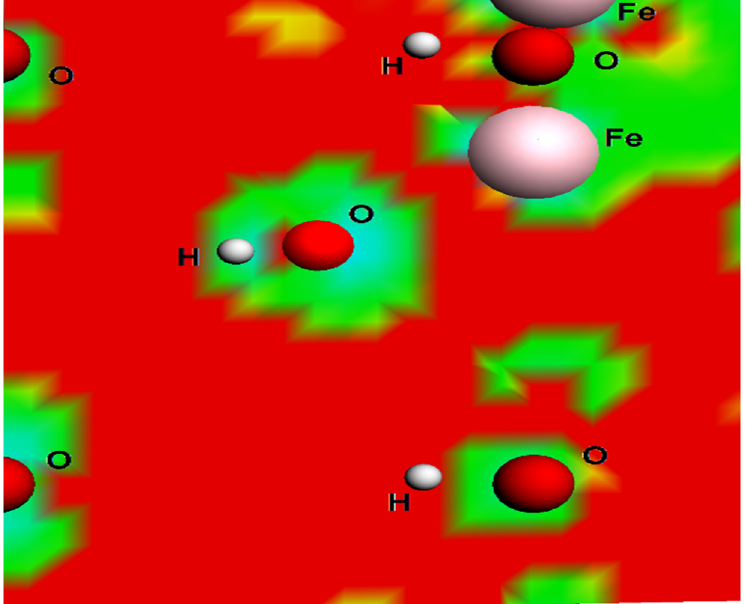
Figure 7. Electrostatic surface contours of (cid:2012) -FeOOH plane (100). Red and green indicate volumes of low electron density and high electron density, respectively. low electron density and high electron density,